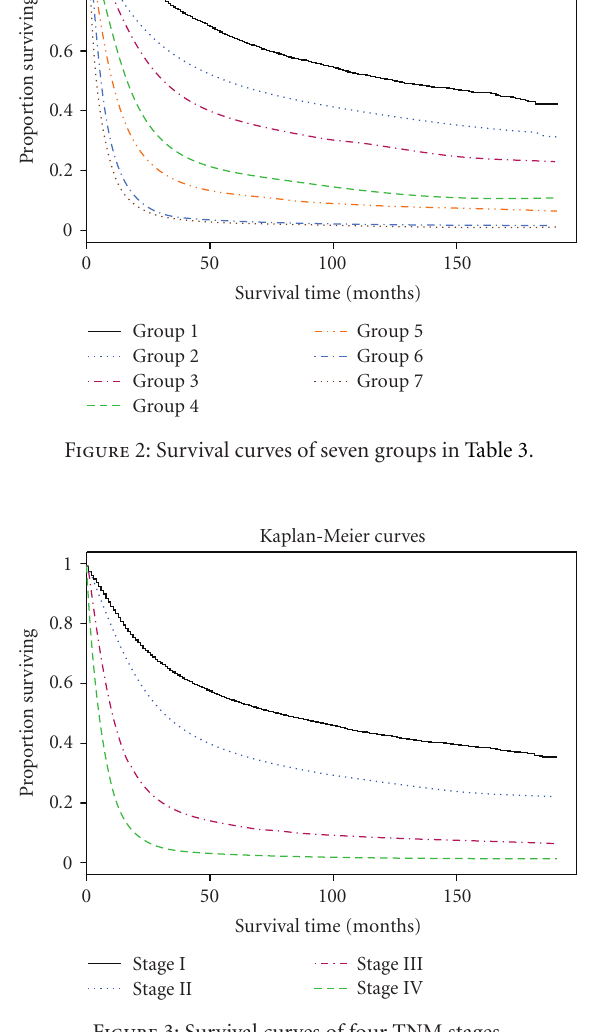
used to obtain the measure (1) for the PAM algorithm. And the average linkage was employed as a hierarchical clustering method.